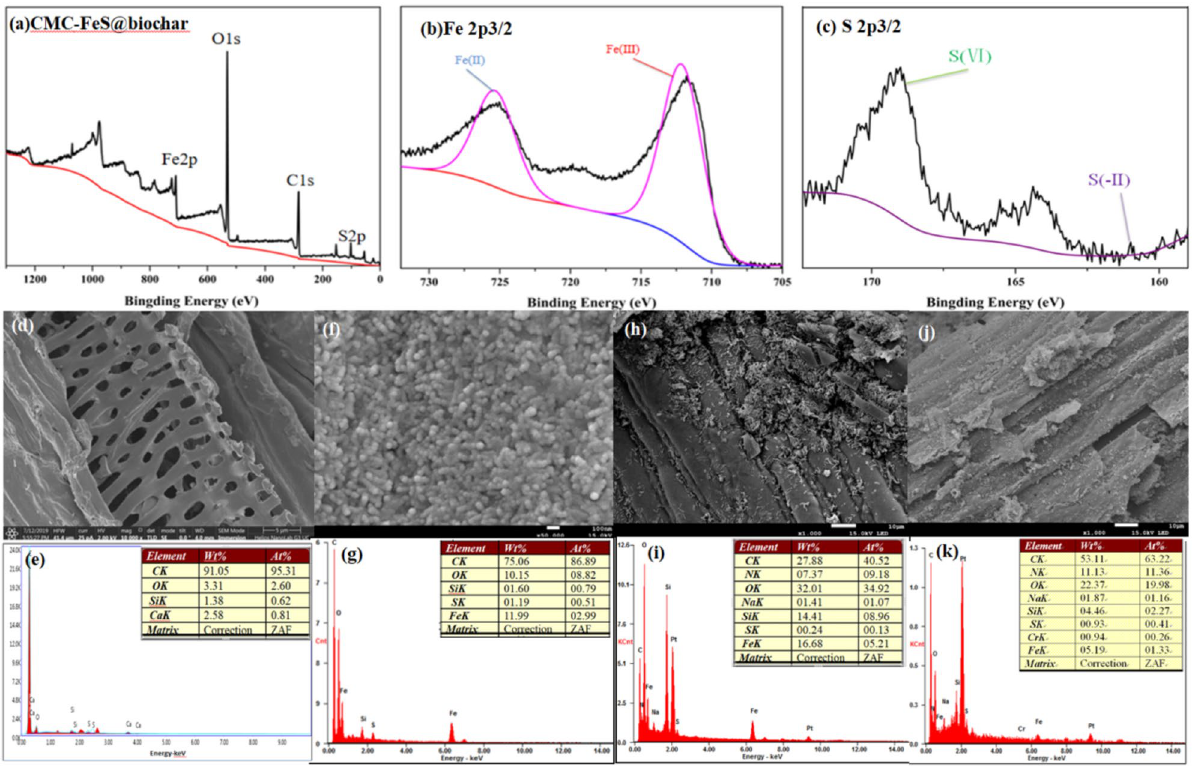
Figure 2. XPS analysis for ( a ) CMC-FeS@biochar, ( b ) highresolution Fe 2 p XPS spectrum, ( c ) high resolution S 2 p XPS spectrum. SEM–EDS analysis of ( d – e ) biochar, ( f – g ) CMC-FeS@biochar, ( h – i ) CMC-FeS@biochar and